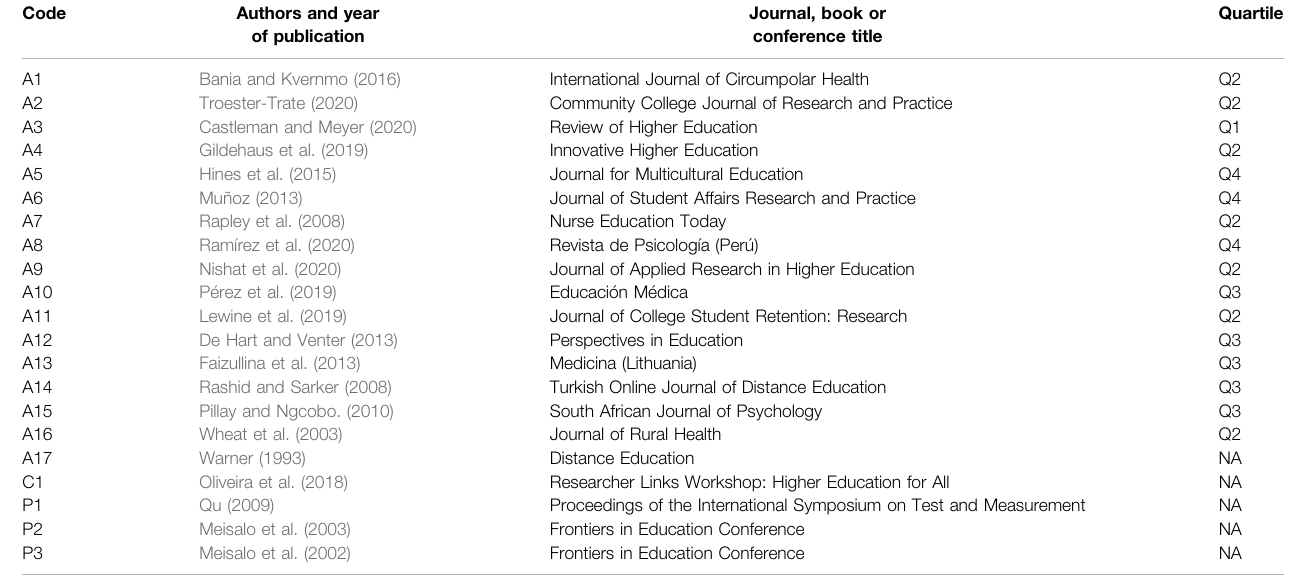
TABLE 2 | Documents in the sample under